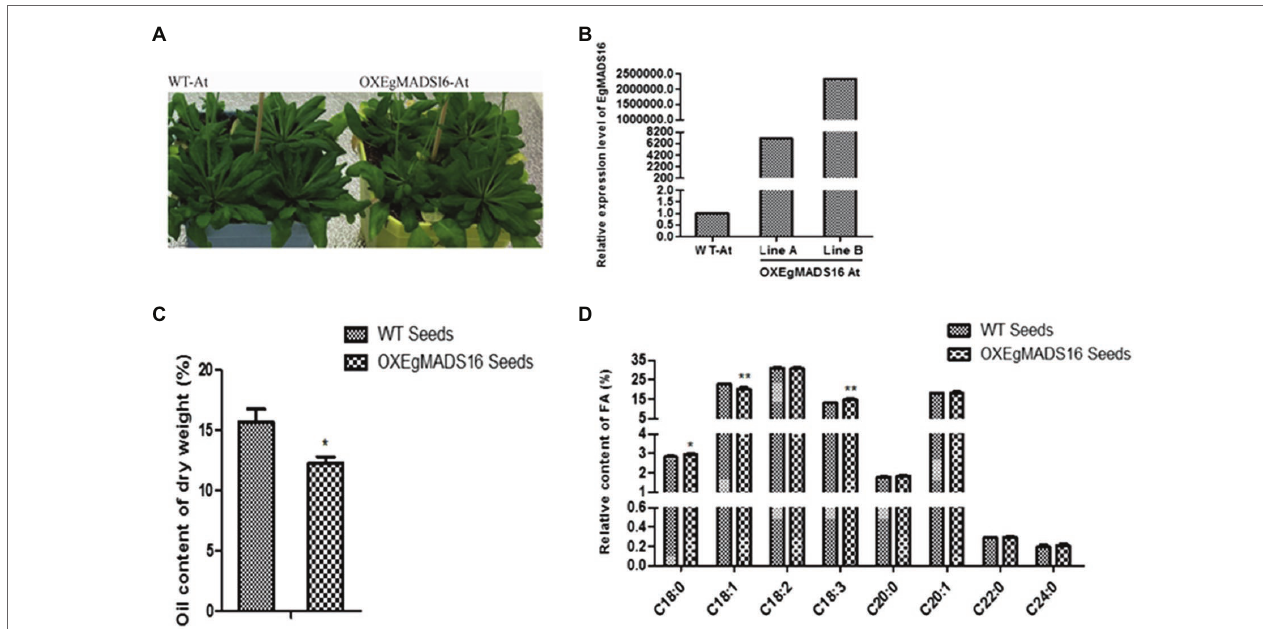
FIGURE 4 | Effect of EgMADS16 on lipid biosynthesis in oil palm embryonic callus. (A) Wild-type oil palm (WT-OP) embryonic callus and EgMADS16 overexpression oil palm embryonic callus (OXEgMADS16 OP) on screening medium containing glufosinate ammonium. Scale bar, 3 mm. (B) The relative expression level of EgMADS16 in WT-OP and OXEgMADS16 OP. (C) The oil content of WT and OXEgMADS16 oil palm embryonic callus. (D) The relative FA content of WT and OXEgMADS16 oil palm embryonic callus. The values are the means ± SD ( n = 3), “*” represents a significant difference ( p < 0.05), and “**” represents a highly significant difference ( p < 0.01) using Student’s t